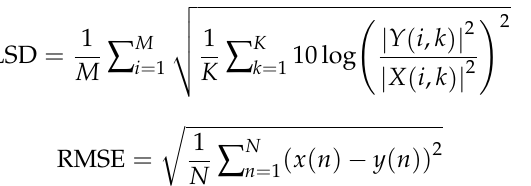
Table 1. LSD and RMSE between recorded and generated signals.